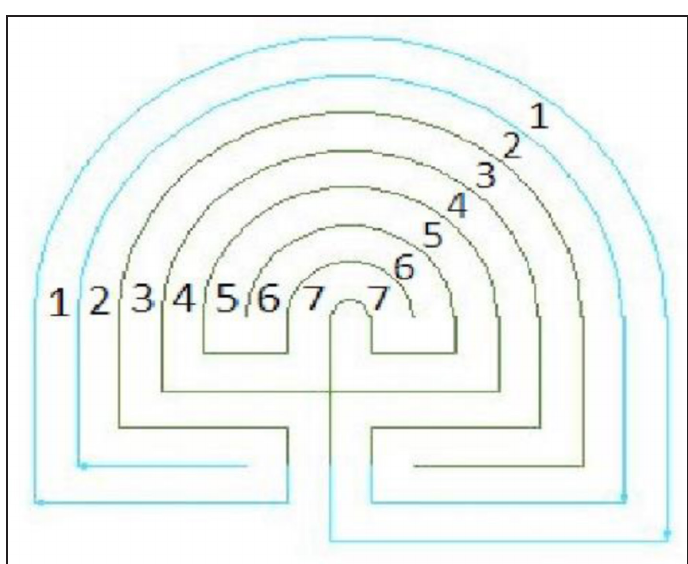
Figure 7: Order of circuits traversed by path. Photo: Nm5mini. “How to do labyrinth.” November 12, 2007. Wikimedia Commons . Public Domain. ShareAlike: original image cropped and numbers added. Accessed January 15, 2018.